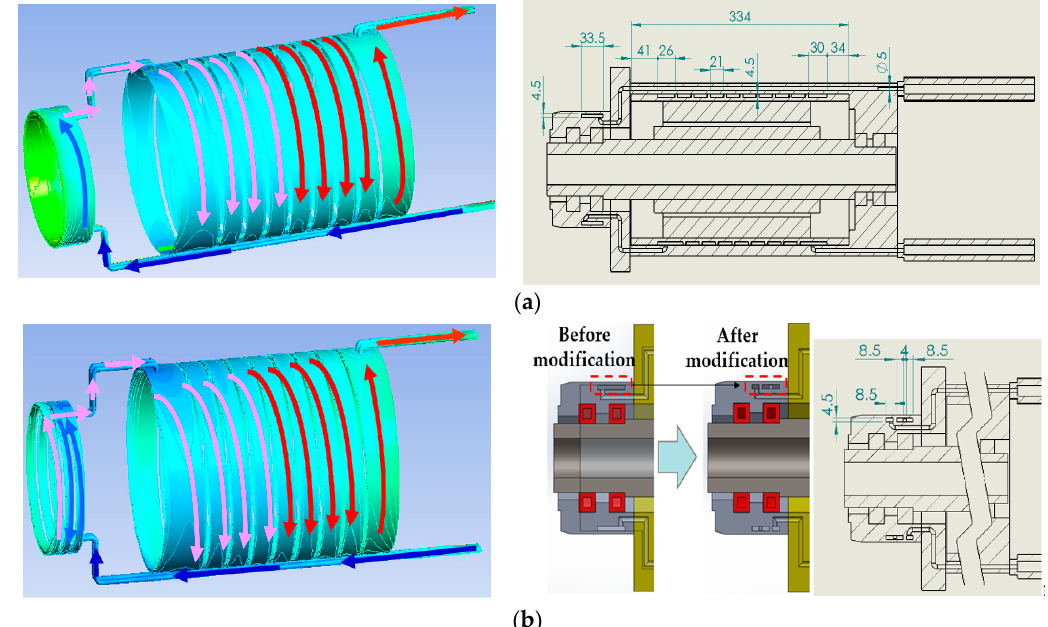
Figure 2. Cooling channel types. ( a ) Helical type; ( b ) paralleling type; ( c ) axial type; ( d ) trapezoidal type; ( e ) single-turn type for bearing; ( f ) paralleling type for bearing.